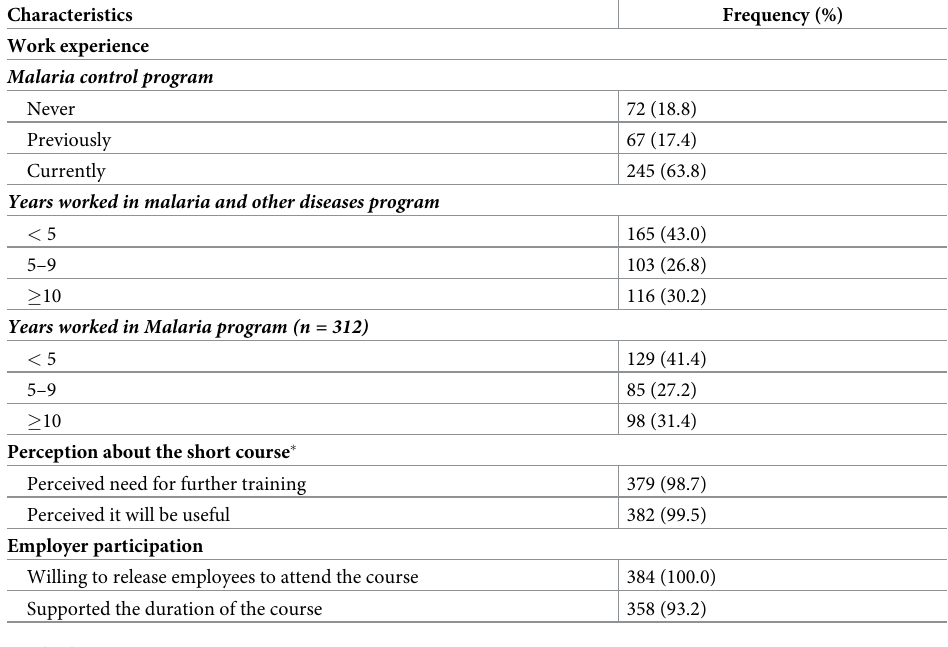
Table 2. Respondents’ work experience and perception of the training course (N =